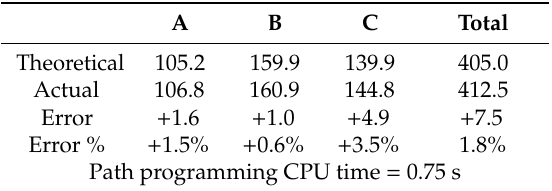
(Actual) under the Constraint of Maximum Distance Limit 164 m for Each Car.